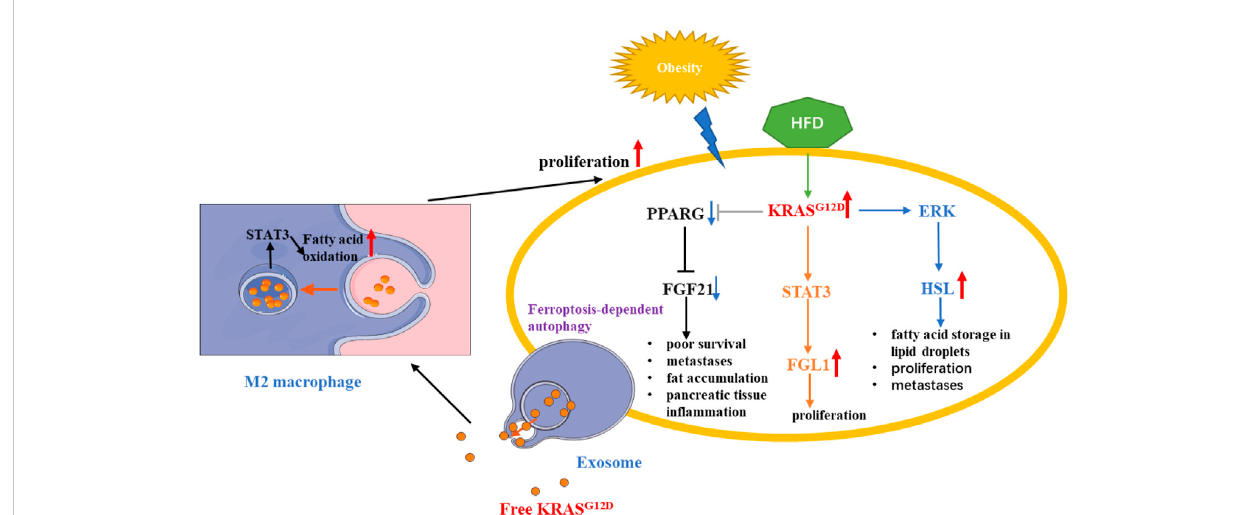
FIGURE 6 KRAS mutation in PDAC fatty acids metabolic reprogramming. KRAS mutation could alter lipid metabolism and promote the proliferation of PDAC cells by regulating STAT3/FGL1, FGF21, HSL. In addition, Autophagy-dependent PDAC cells releasing exosome, which contains KRAS G12D , can promote fatty acid oxidation bySTAT3 in M2macrophage. Red arrow: The expressionofrelated gene isupregulated. Blue arrow: The expressionofrelated gene is